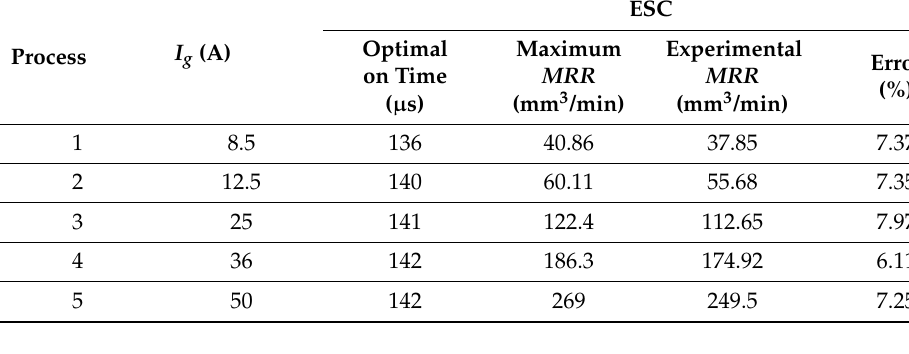
Figure 11. MRR comparison of manual and ESC searching. Figure 12. ( a ) EDM arrangement and ( b ) machine surface using SEM.